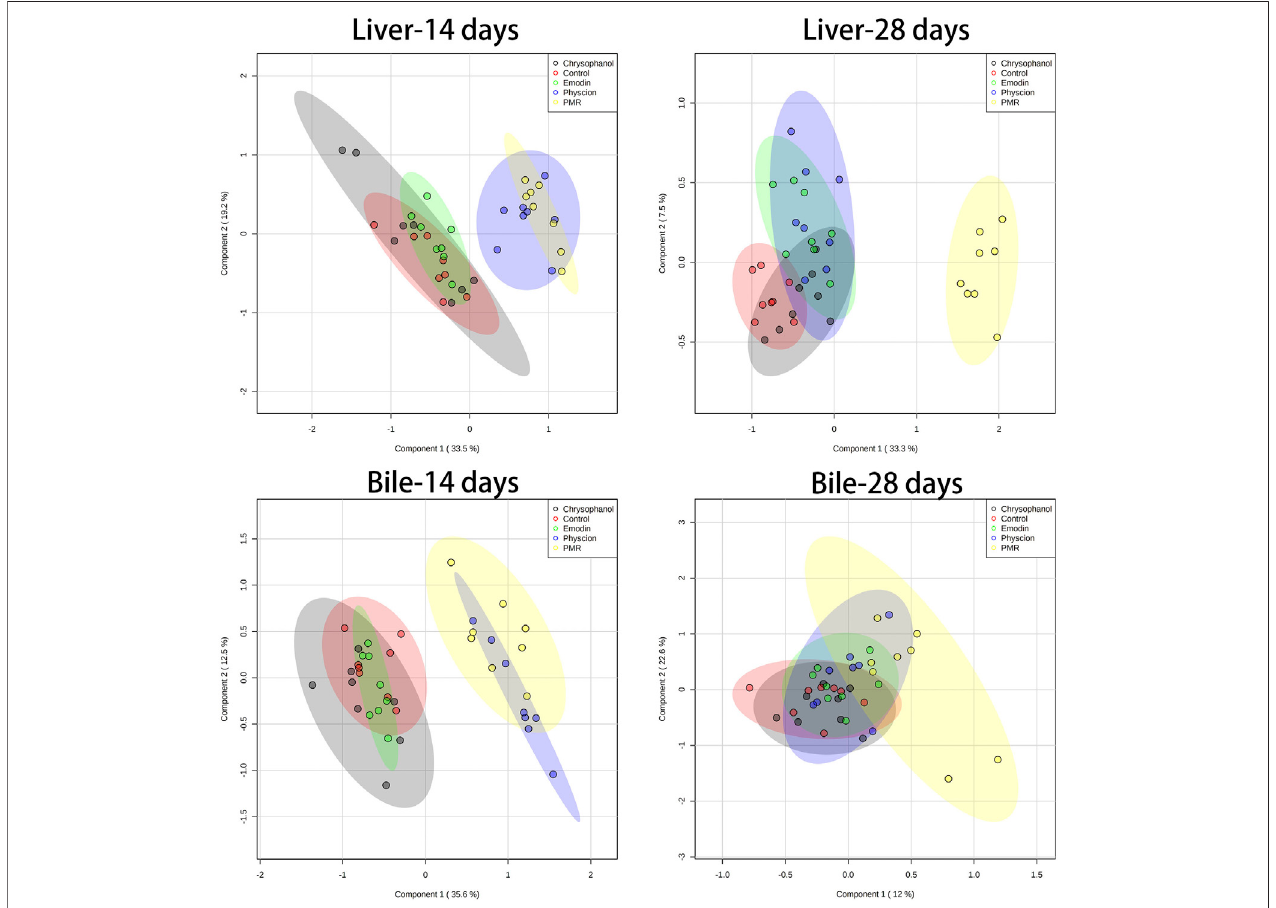
FIGURE6| PLS-DAresultsbasedonthequantitativeanalysisoftheBAsinthemouseliverandbilefromdifferentgroupsofmicefollowing14-or28-daytreatment with anthraquinones or PMR extract.